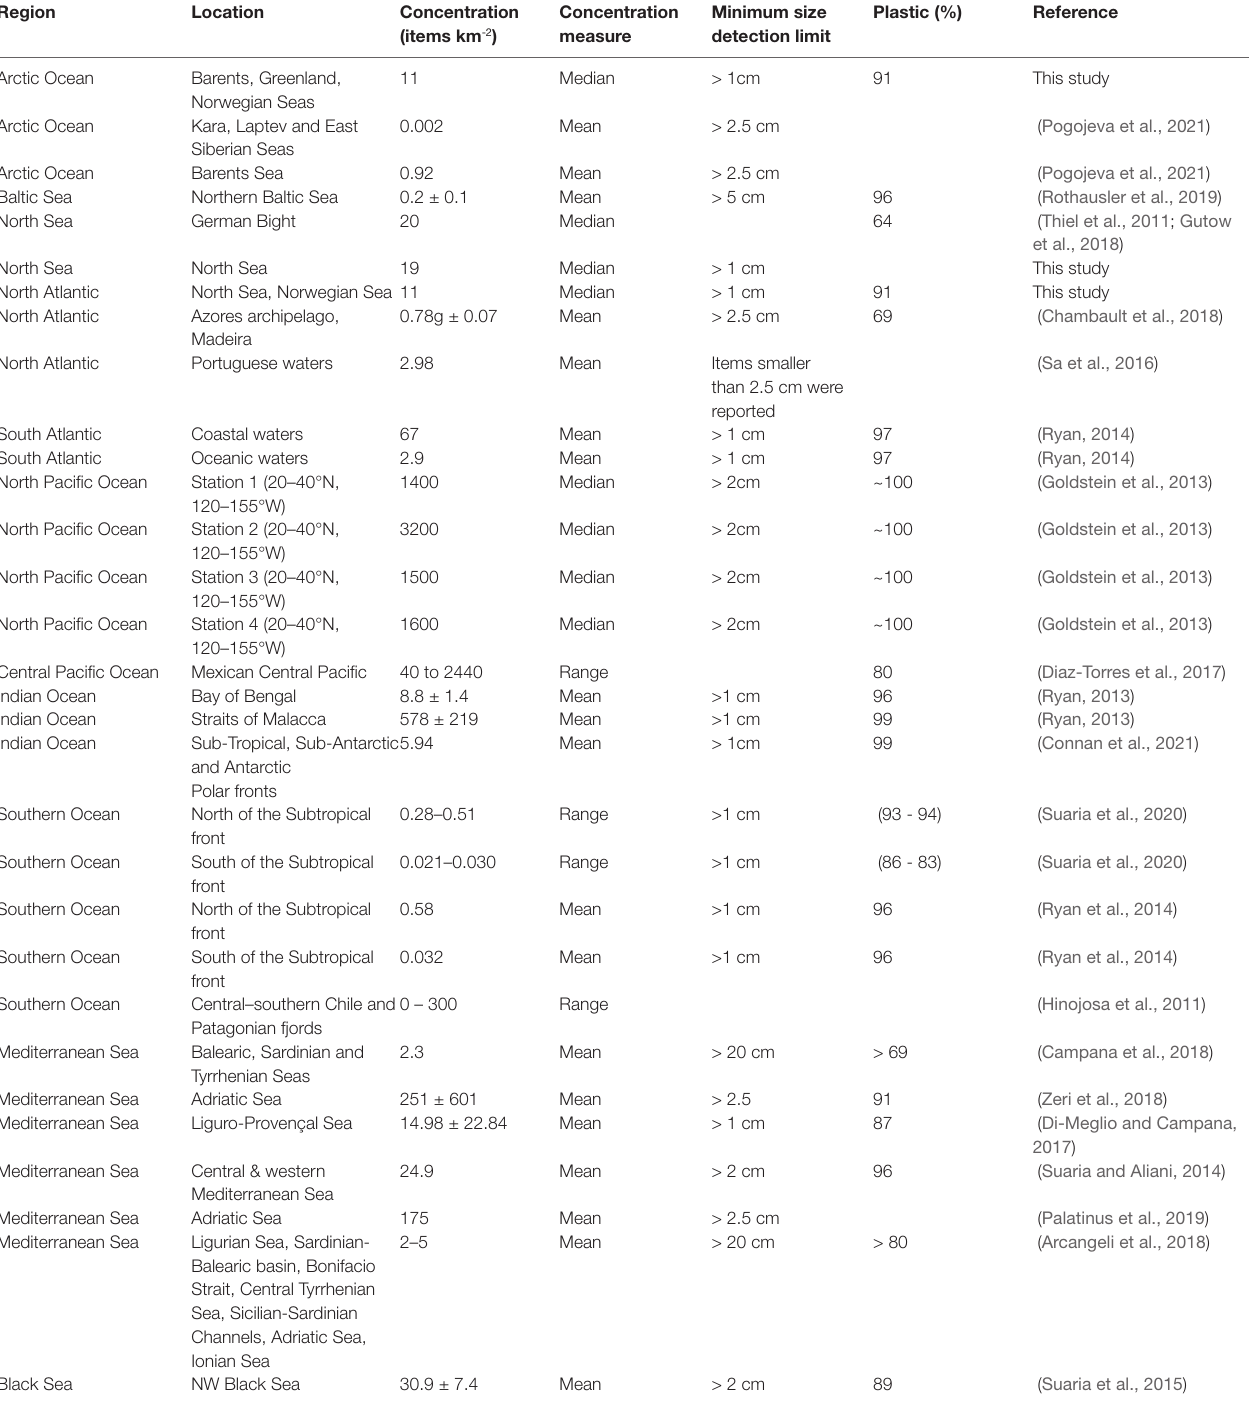
TABLE 2 | Floating marine debris concentrations reported in items km -2 by visual surveys after